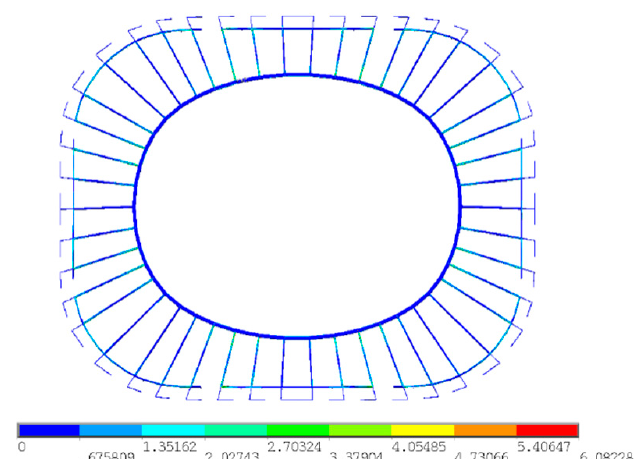
10 of 18 Figure 5. Construction process: ( a ) Step 1, ( b ) Step 2, ( c ) Step 3, ( d ) Step 4, ( e ) Step 5, ( f ) Step 6. Zero-stress state form-finding components: columns, ring transfer beam, internal compression ring, and outer radial girders. Force-finding components: radial cables, radial girders, internal compression ring, hoop cables, and V columns’ outer and inner branches. 4.3. Zero-Stress State Form-Finding Results The most important characteristic of the structure in the zero-stress state is that the structural stress is zero or close to zero. Figure 6 shows that in the zero-stress state ob- tained by the PSEFF method, the maximum stress of the form-finding structure is 6.1 MPa,